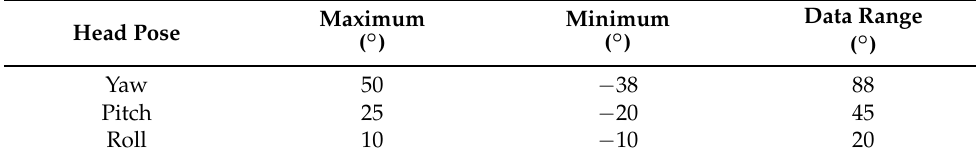
Table 1. Dataset head pose